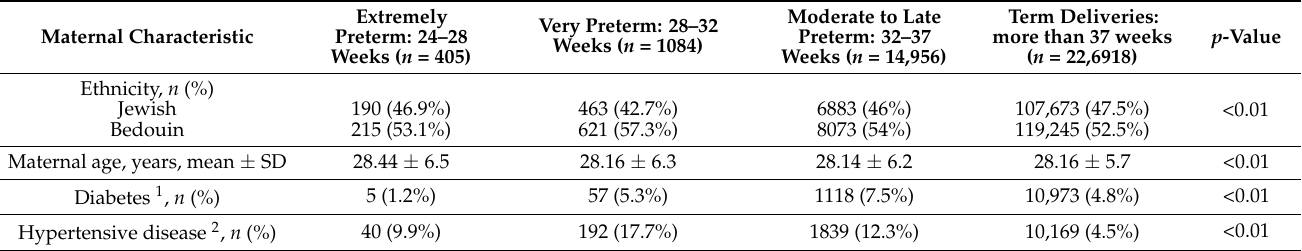
Table 1. Maternal characteristics according to gestational age.